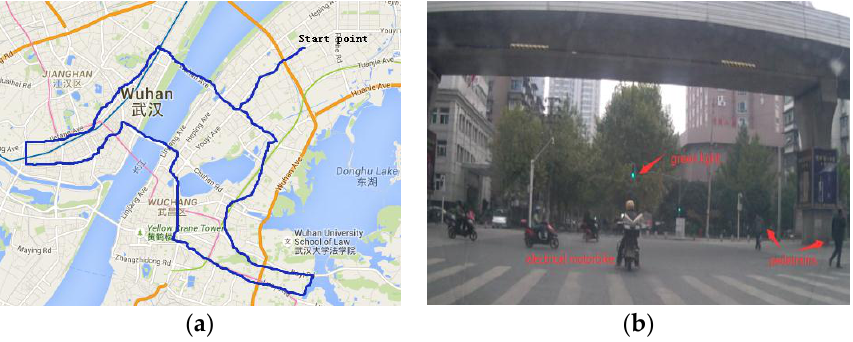
Figure 2. The test route and traffic environment during on-road experiment process. ( a ) The test route (blue line); ( b ) Stimulation events in traffic environment.